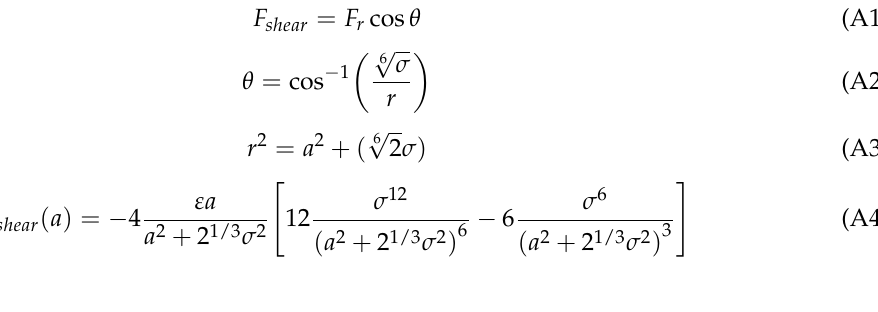
Figure A1. Tangential force component in atomic separation.